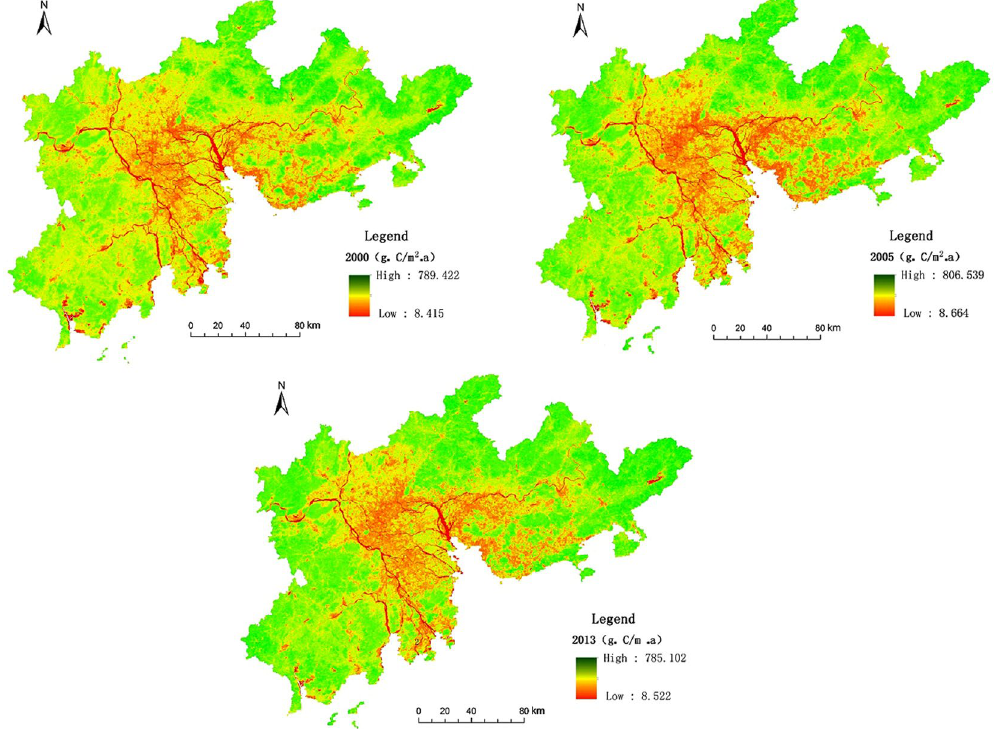
Figure 1. Spatial distribution of carbon sinks in the Pearl River Delta region. Map created using ArcMap (version 10.2) software from Esri